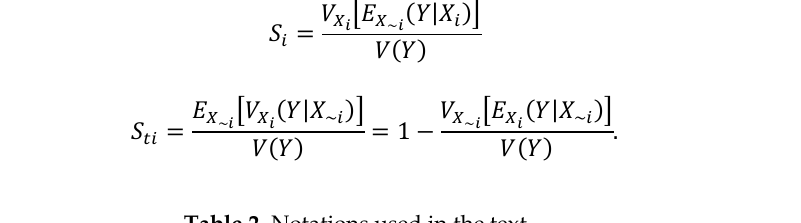
Table 2. Notations used in the text.